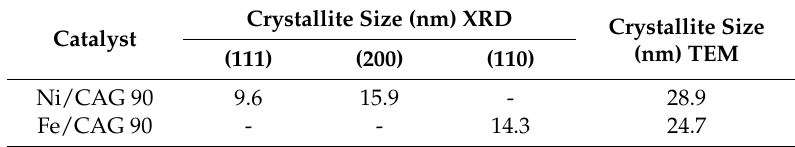
Catalyst Table 7. XRD crystallite size (Equation (1)) for selected Ni and Fe crystal planes in both catalysts. Catalyst